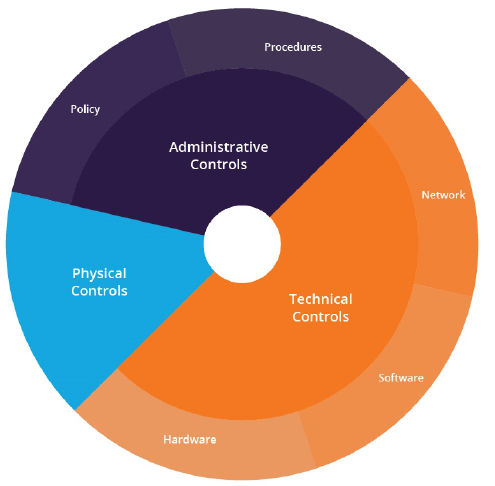
Figure 2. Example of the layered security architecture of the defense-in-depth